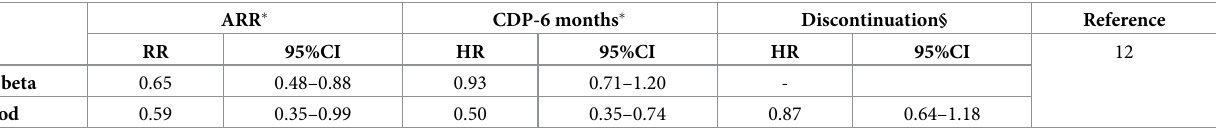
horizon, was the result of the cost difference between the two scenarios.